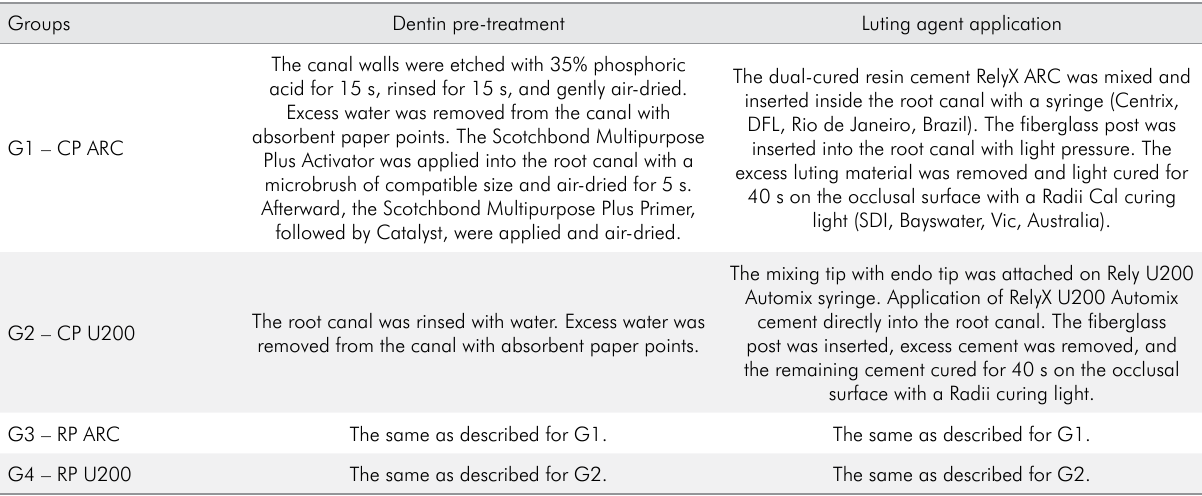
Table 1. Bonding procedures applied in the experimental groups. Groups Dentin